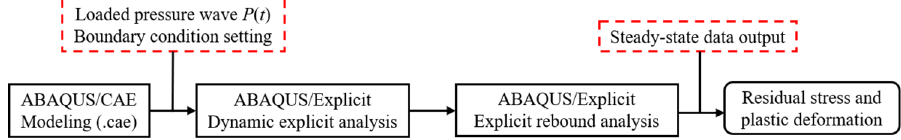
Figure 2. LSP simulation process.